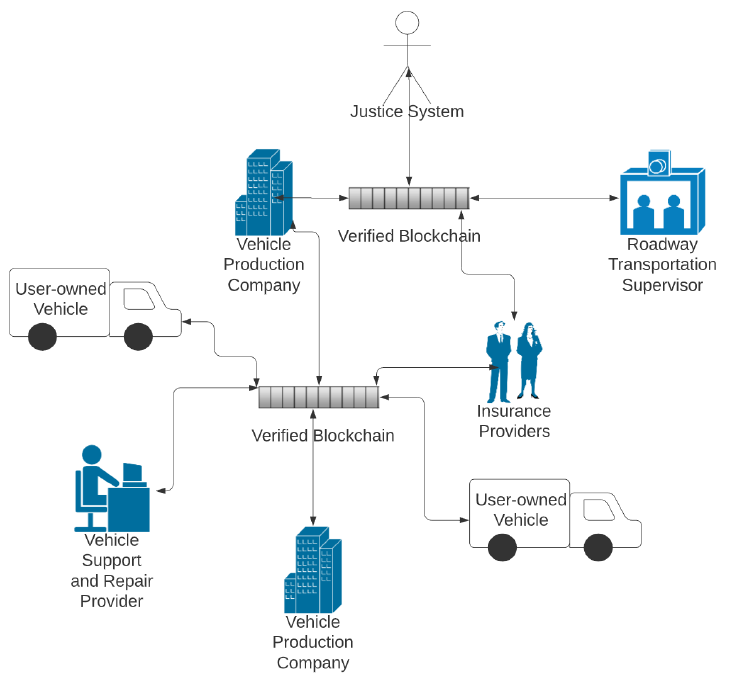
Figure 15. A model outlining the basic proposed operation of a blockchain-based information- gathering system to validate and collect accident details, inspired by [97].